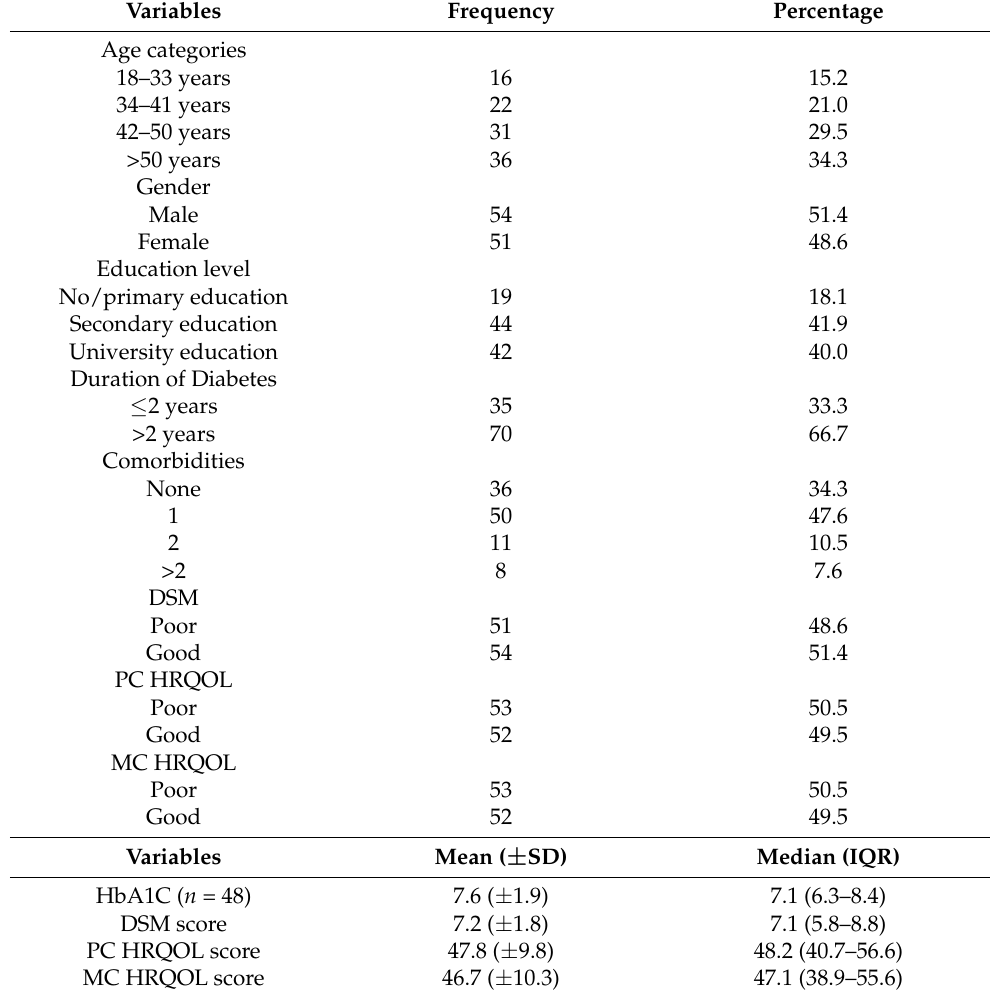
Table 1. Baseline characteristics of the